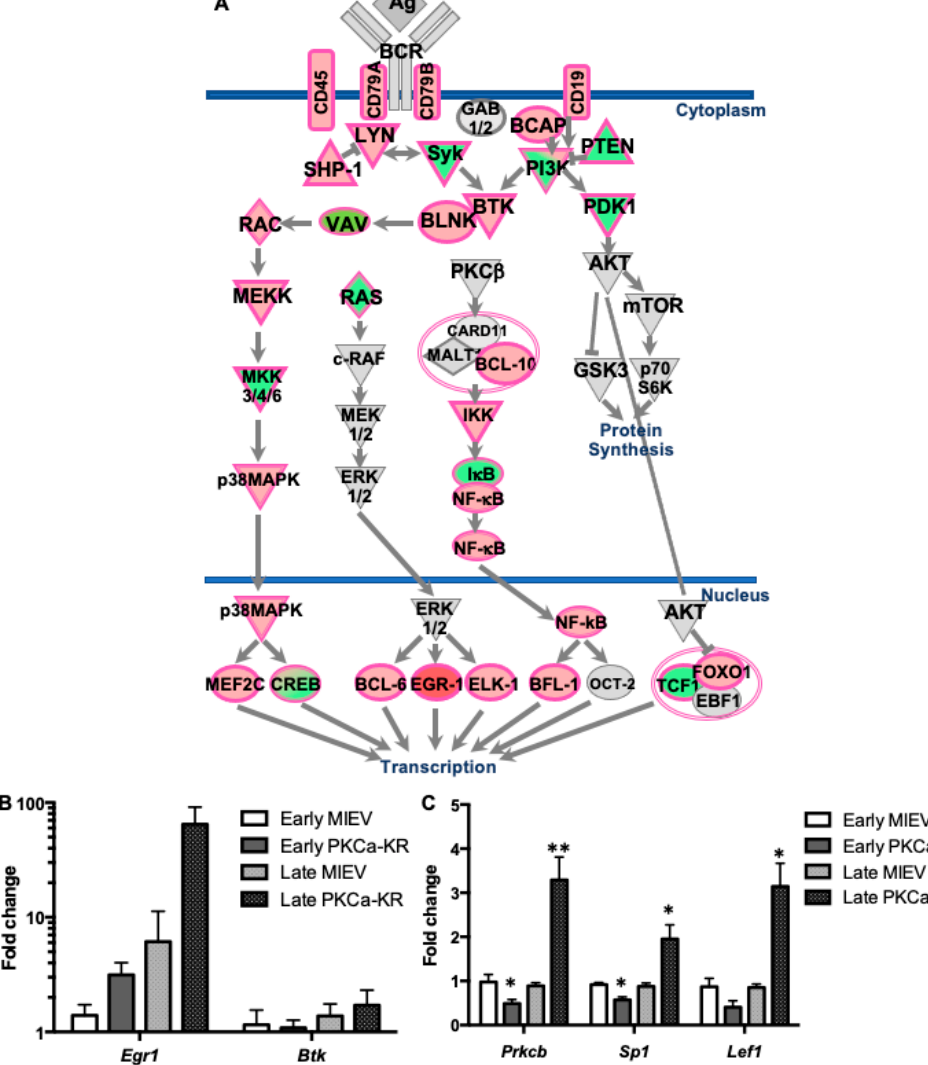
Figure 4. Global gene expression analysis revealed activation of the BCR-mediated signalling pathway in PKC α -KR cells. Global RNA analysis was performed using Affymetrix GeneChip mouse gene 1.0 ST on MIEV and PKC α -KR transduced cells at d17–23 in the B cell transformation co-culture. ( A ) Dysregulated components of the BCR pathway in PKC α -KR vs. MIEV cells isolated from late co-cultures ( n = 5 PKC α -KR, n = 5 MIEV) were identified. Significantly up- and down-regulated components are highlighted in pink/red and green, respectively; ( B ) qPCR validation of egr1 and btk genes, which were both upregulated in the microarray analysis at the late stage (d15–23) of B cell transformation, compared with the early stage (d6–10). Data are an average of n = 2–4 biological replicates, normalised to tbp . ( C ) Comparison of prkcb , sp1 and lef1 gene expression in the early vs. late stages of B cell transformation co-cultures, determined by qPCR. Data represent n = 3–5 biological replicates, normalised to gapdh . Unpaired student t -tests were used to analyse the data. * p < 0.05, ** p < 0.01.